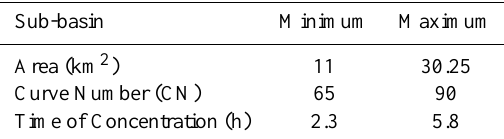
Table 1. Hydrologic element